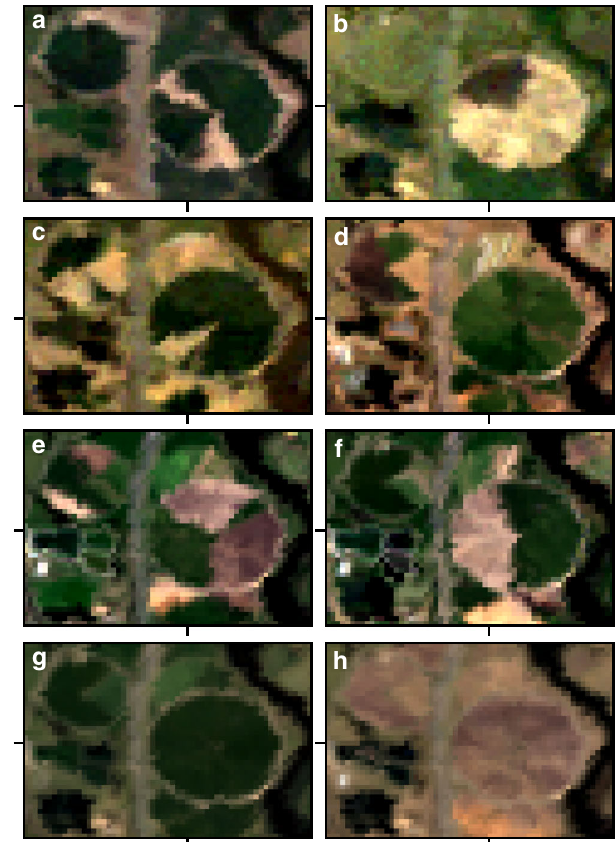
Fig. 2 Test area at different time epochs compared to the Barest Earth and Most Vegated outputs. The local study area at 6 different observation times ( a – f ) compared to g the Most Vegated output and h the Barest Earth output (Landsat 30 + year). The Most Vegated output is generated by inverting the Barest Earth algorithm to get the opposite response.